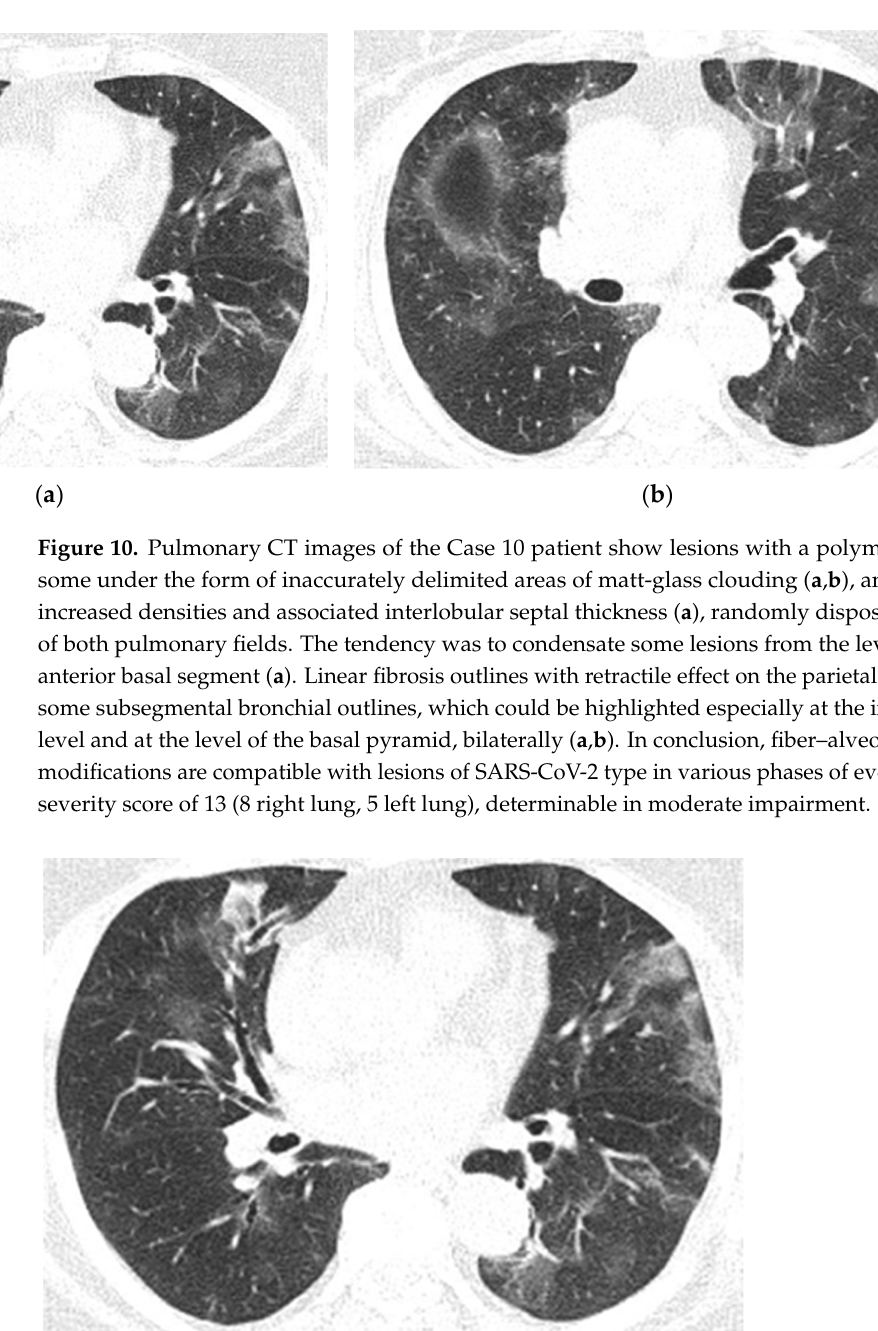
Figure 11. In evolution, CT images of the Case 10 patient show important numerical and dimensional progression of pulmonary lesions randomly distributed on more than 70% of the entire surface of both pulmonary fields. In conclusion, bilateral pulmonary condensations of SARS-CoV-2 type were in progress, with a severity score of 20 (13 at previous examination) and were determined to exhibit a severe degree of disorder.